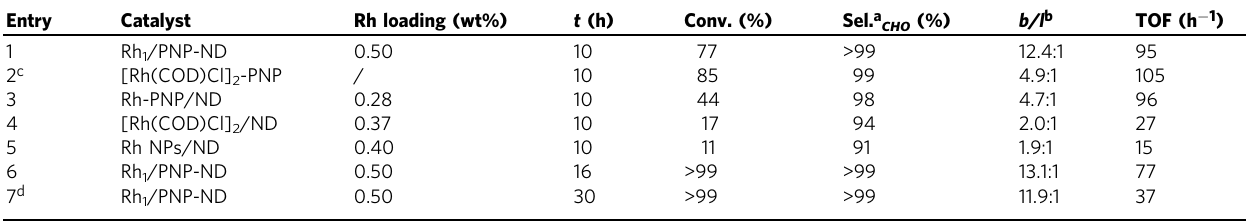
Table 1 Screening of various Rh catalysts in the hydroformylation of styrene.